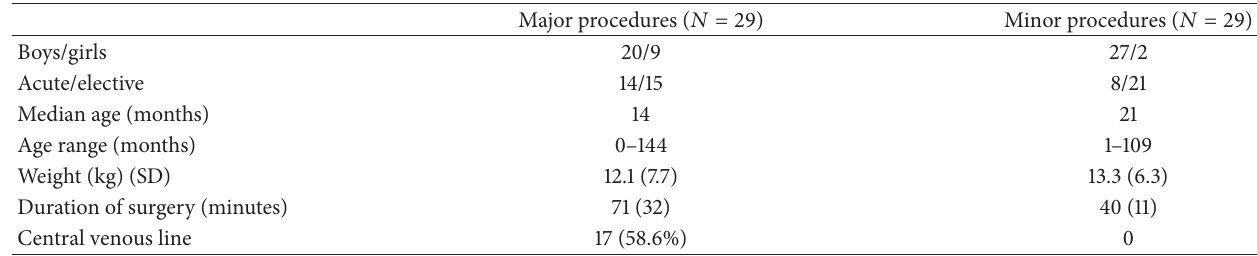
Table 2: Demographic characteristics of the two groups.